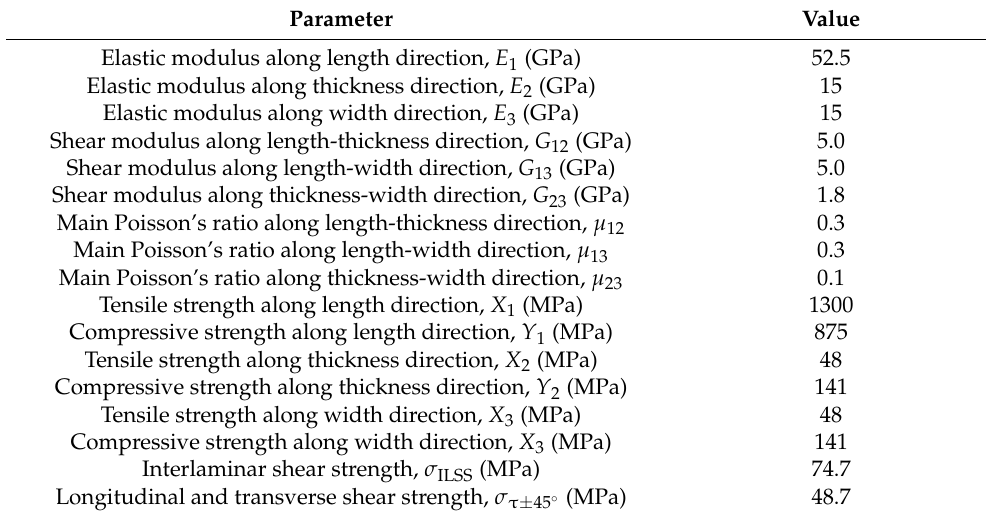
Table 4. Mechanical property parameters of E-glass fiber/epoxy composite material